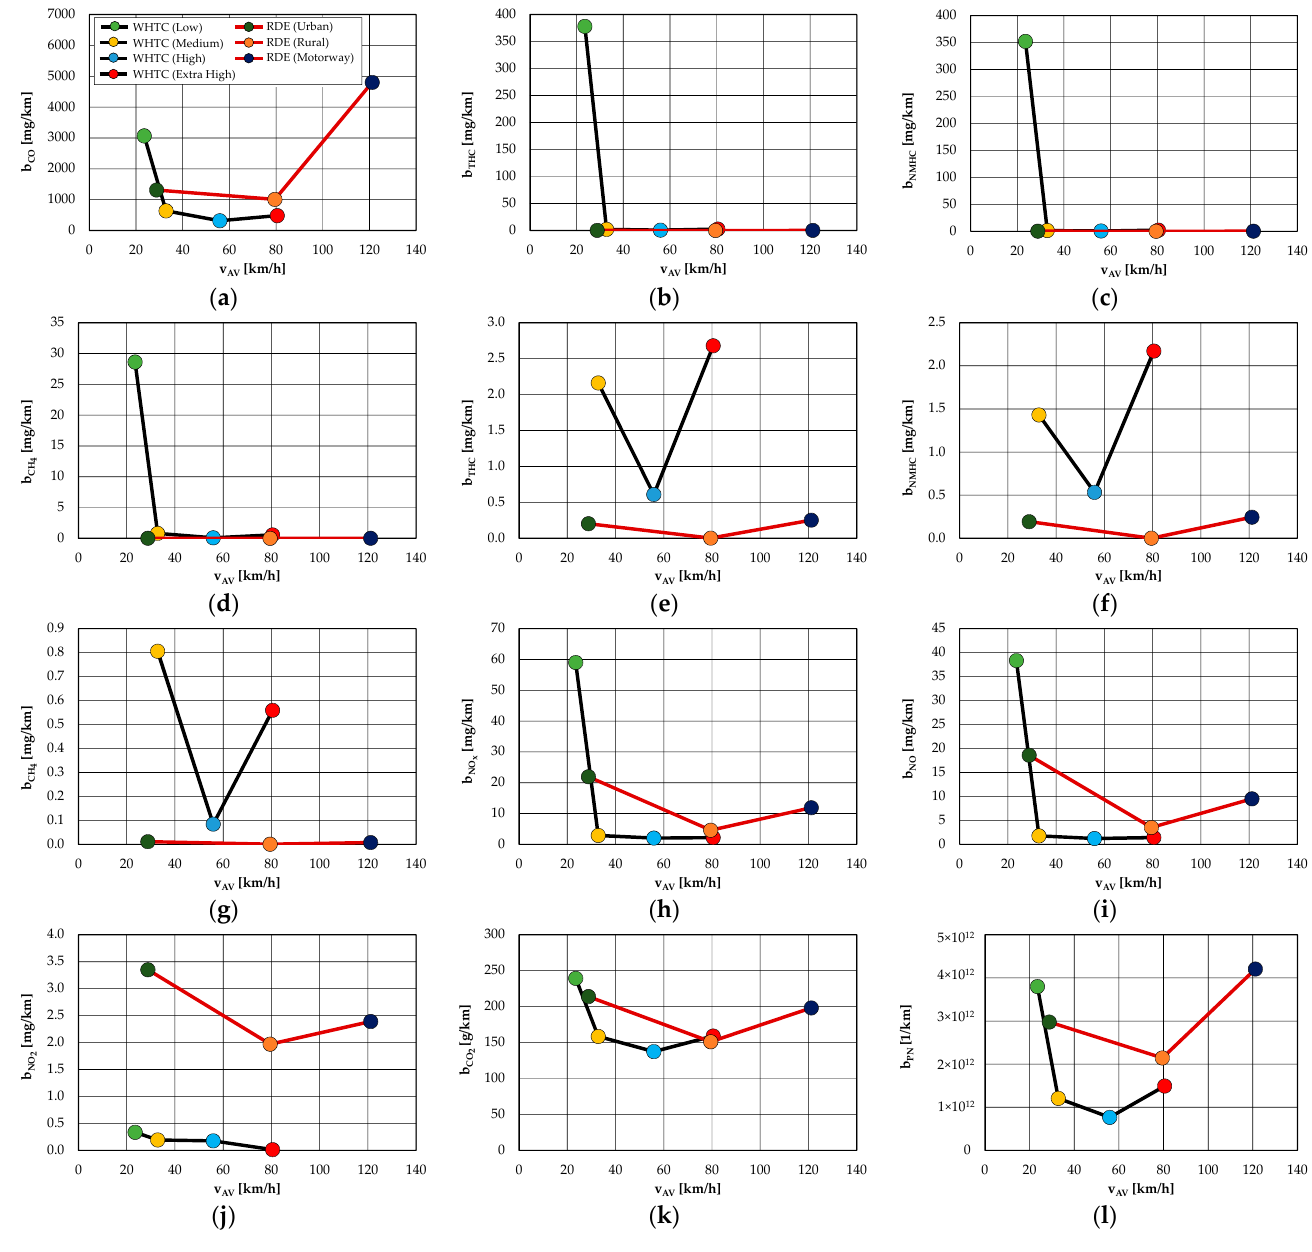
Figure 5. The relationship between the road exhaust emissions and the test vehicle driving speed in the WLTC and RDE tests for: ( a ) carbon monoxide; ( b ) hydrocarbons; ( c ) non-methane hydrocar- bons; ( d ) methane; ( e ) hydrocarbons w/o cold-start; ( f ) non-methane hydrocarbons w/o cold-start; ( g ) methane w/o cold-start; ( h ) nitrogen oxides; ( i ) nitrogen oxide; ( j ) nitrogen dioxide; ( k ) carbon dioxide; ( l ) number of emitted particles.